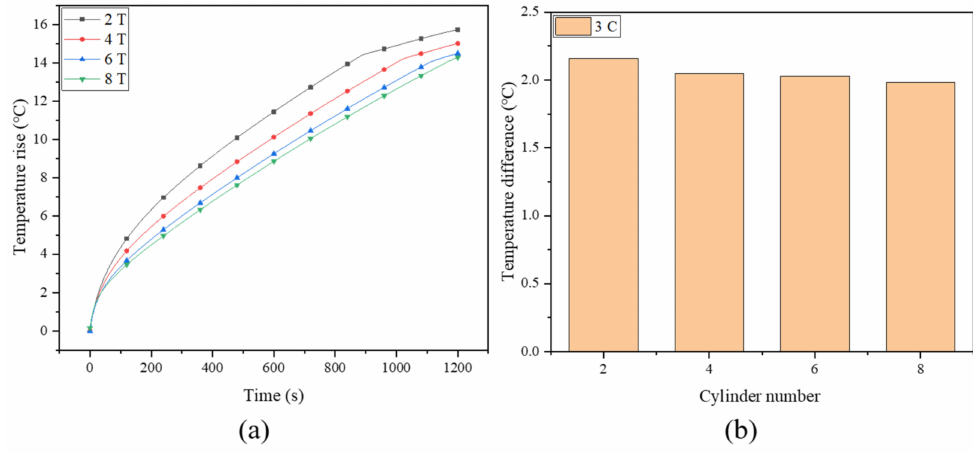
Figure 9. ( a ) Maximum battery temperature rise and ( b ) temperature difference of battery with different fin turns.